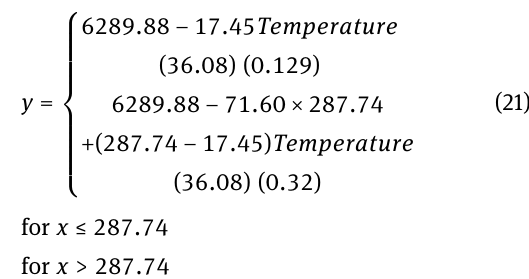
for x > 287.74 Gradient boosting [44] and neural network machine learning algorithms used in the study are based on the ex- traction of the influential data features for models’ train- ing. The main features of the energy consumption time series are hour, day of week, month, quarter, year, day of week, day of month, week of year. Feature importance according to the gradient boosting tree algorithm is pre- sented in Figure 3. Detailed analysis of the errors of the gradient boosting model revealed the worst prediction accuracy for holidays. Inclusion of holidays’ dummy variable (takes 1 if the